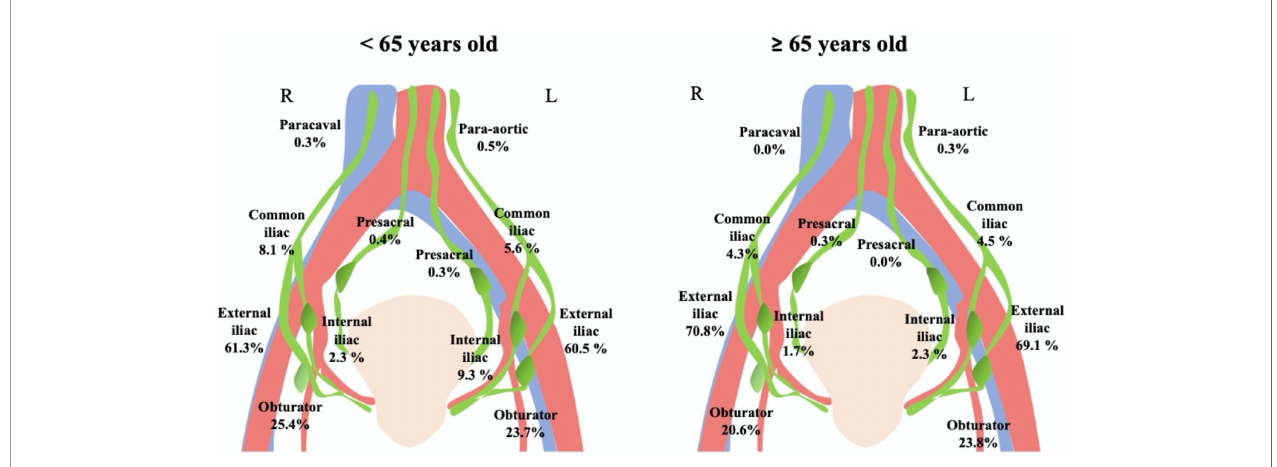
FIGURE 1 | Anatomical localizations of sentinel